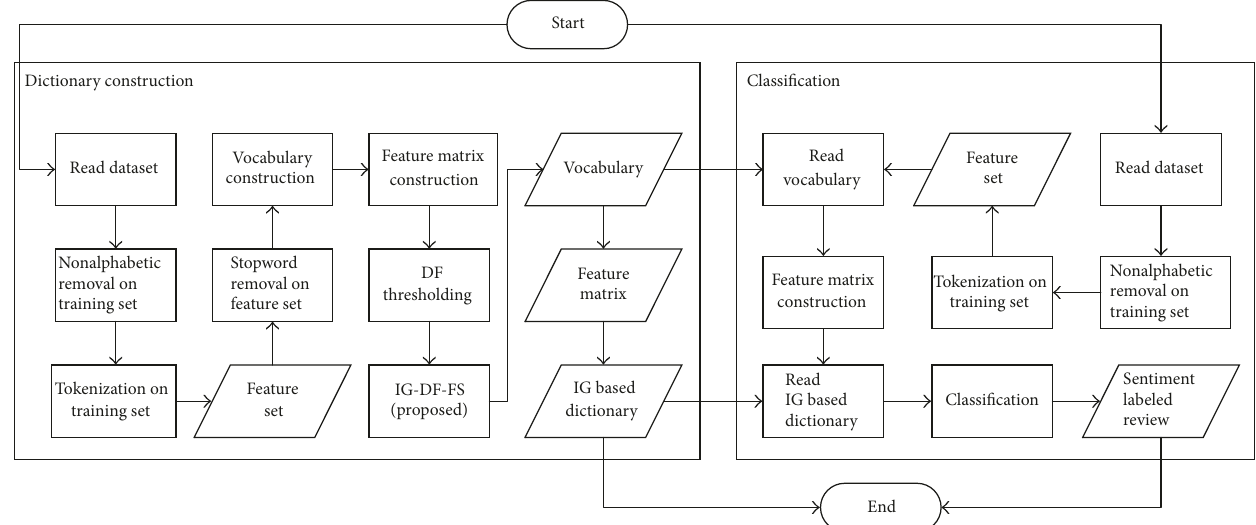
Figure 1: Classification